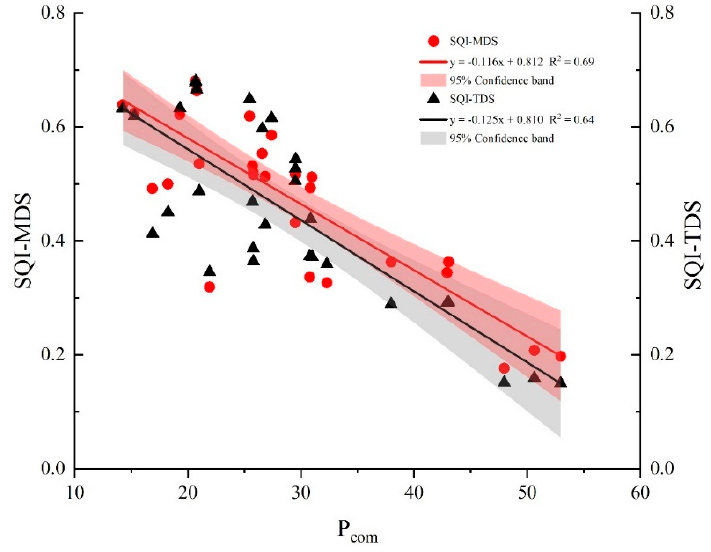
Figure 7. Correlation between SQI and P com ( n = 30).